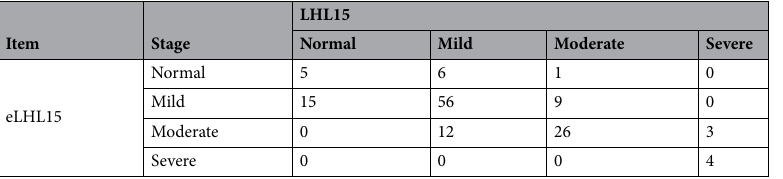
Table 4. Contingency table between the receptor index (LHL15) and the estimated LHL15 (eLHL15) from the liver–spleen contrast (LSC). The stages are based on imaging-based clinical stage classification. All data are expressed as the number of subjects. χ 2 (9) = 131.616, P < 0.00001, Cramer’s V = 0.568, degree of agreement =